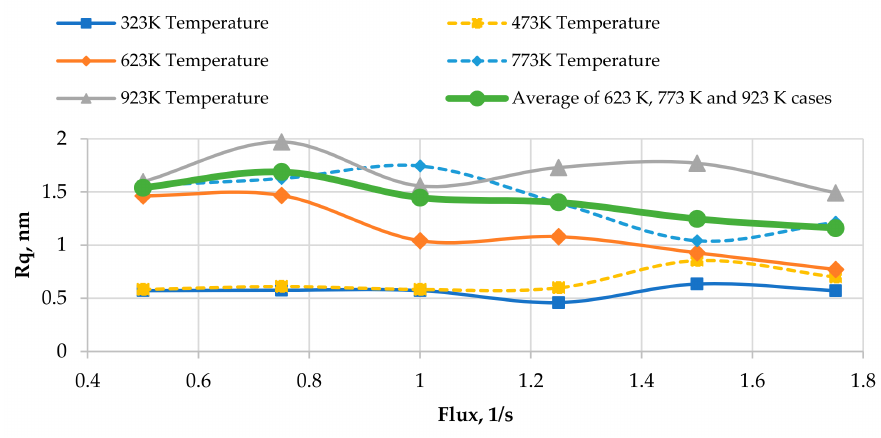
Figure 8. Plots of surface roughness vs. relative flux for di ff erent substrate temperatures.